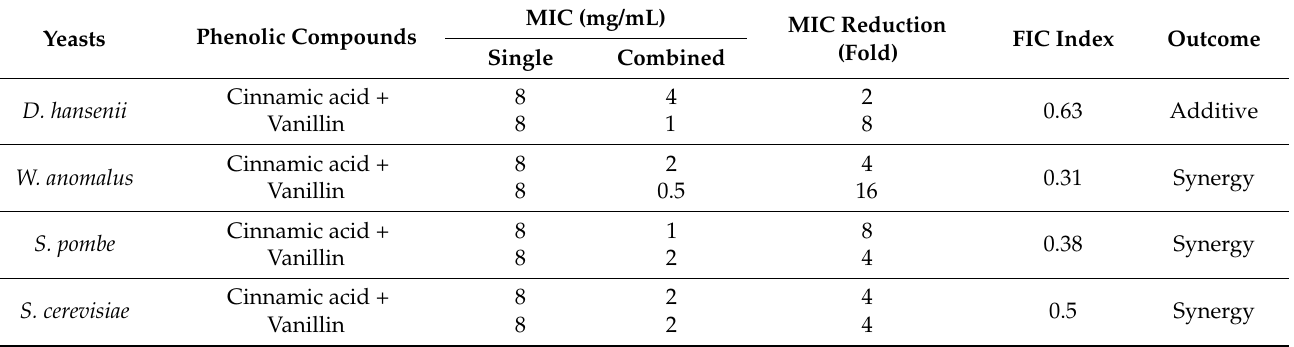
Table 7. Effect of combination of vanillin and cinnamic acid on adhesion on polystyrene surface of food spoilage